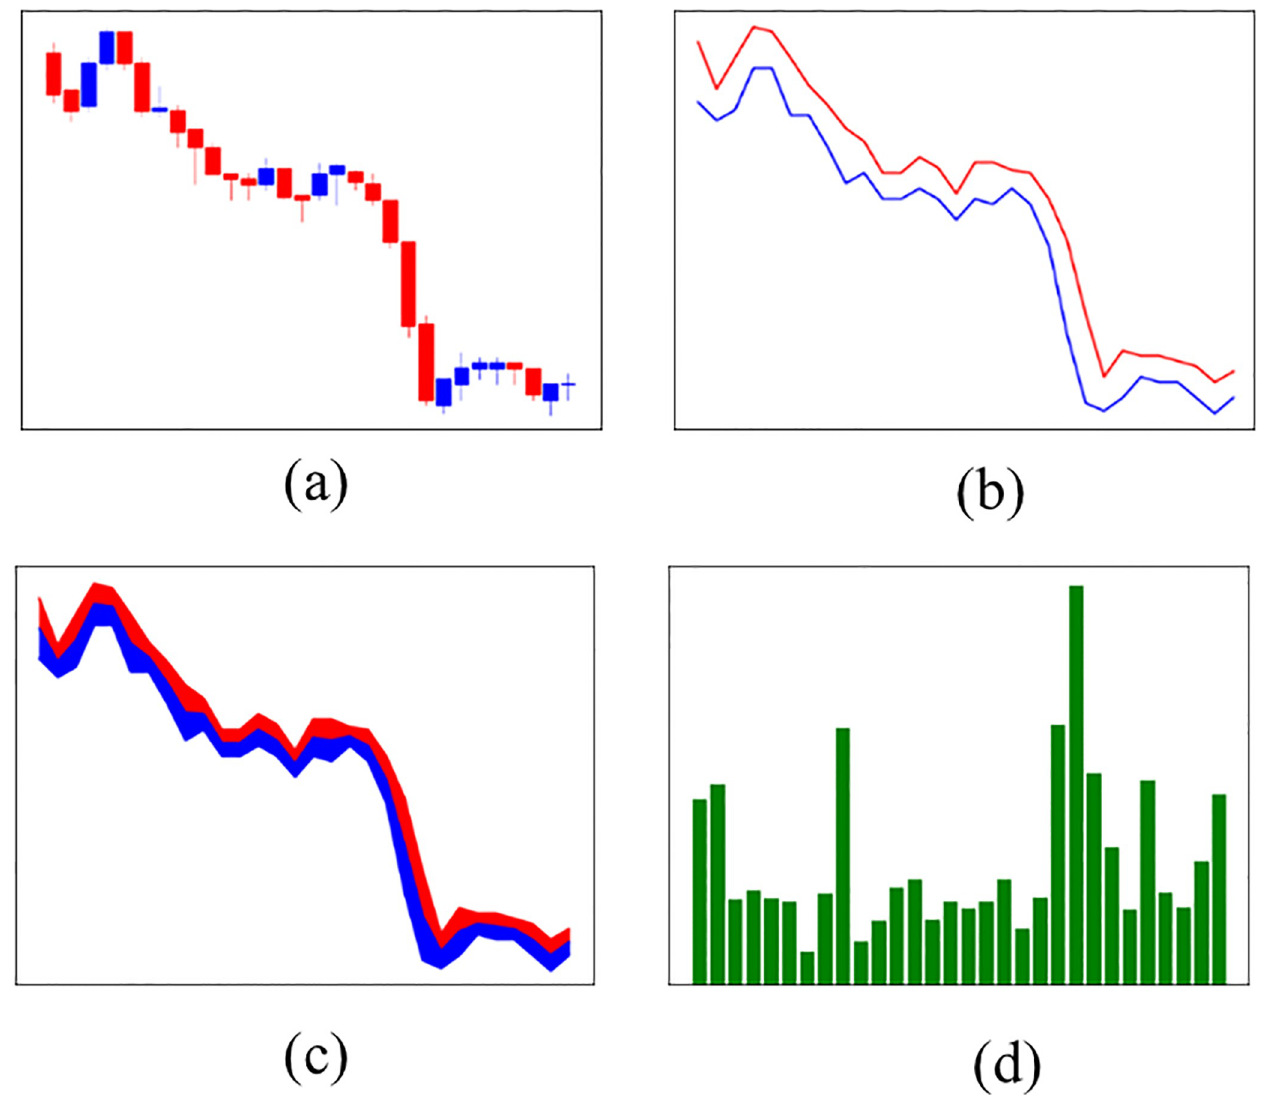
Fig 3. Four stock chart images using SPY data. The time interval is between t − 30 and t . (a) Candlestick chart, (b) Line chart, (c) F-line chart, and (d) Bar chart.